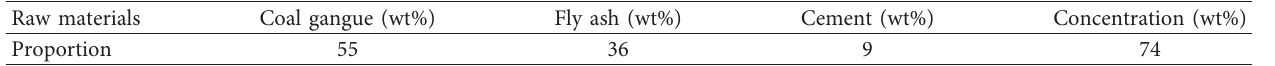
Table 2: Mix proportion of backfill